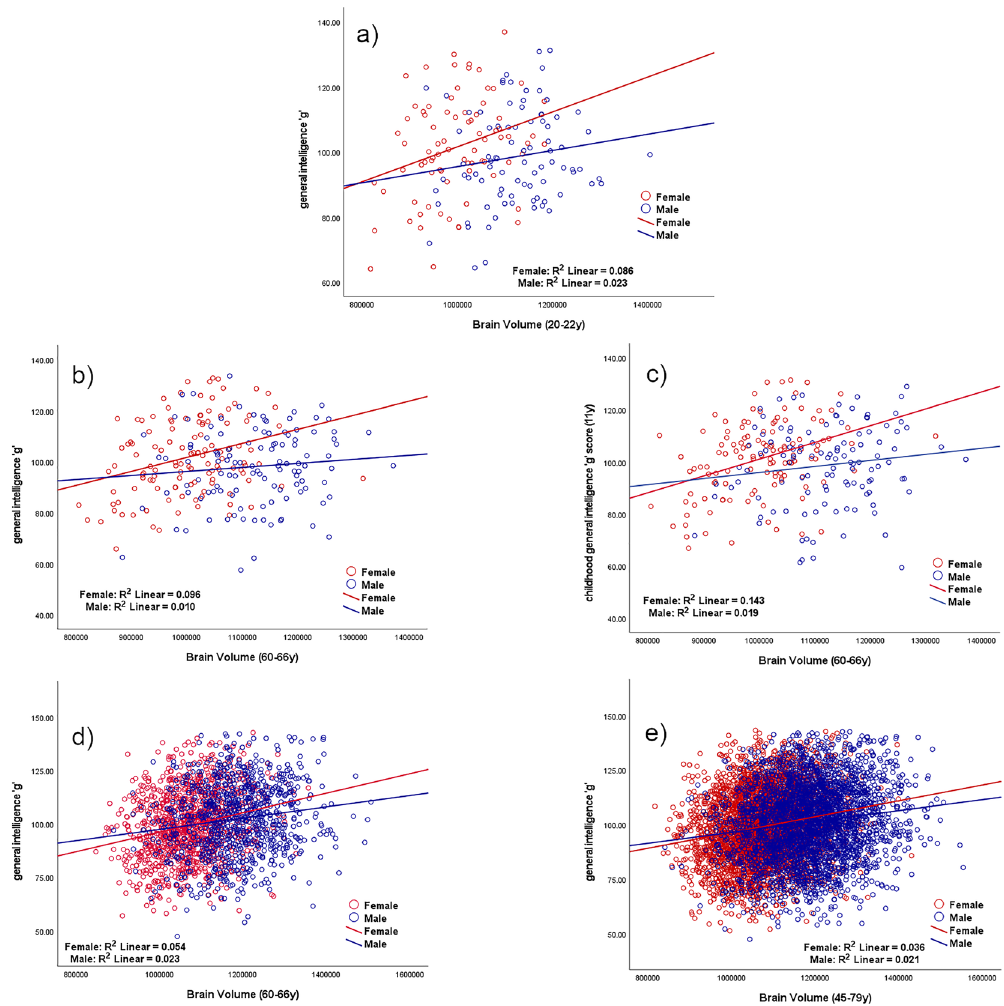
Figure 2. Correlations between brain volume (mm 3 ) and general intelligence g according to sex. ( a ) Mysore Parthenon Cohort (MPC)—correlation between brain volume (mm 3 ) and general intelligence g for women (red) and men (blue) at age 20–22. ( b , c ) ACONF cohort—correlation between brain volume (mm 3 ) and general intelligence g at age 60–66 ( b ) and at age 11 ( c ) for women (red) and men (blue). ( d , e ) UK Biobank—correlation between brain volume (mm 3 ) and general intelligence g at age 60–66 years ( d ) and at age 45–79 years ( e ) for women (red) and men (blue).